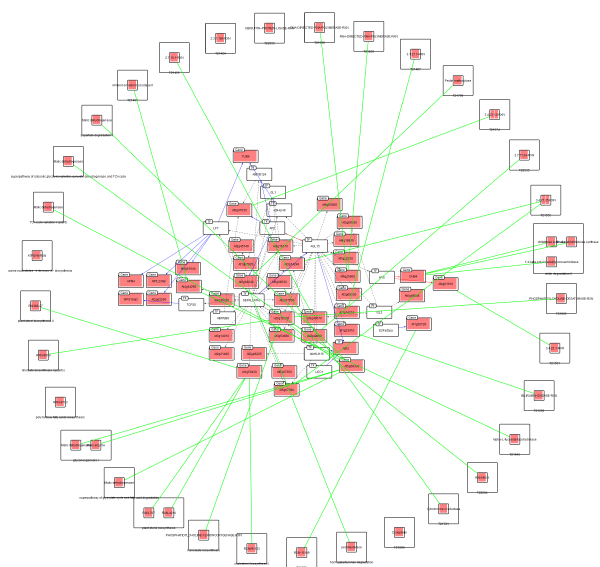
Figure 5: The result for mapped data (selected genes) on the gene regulatory network (in the center) and the surrounding abstract metabolic network. The edges between the networks indicate the same data element (gene Id) found in both